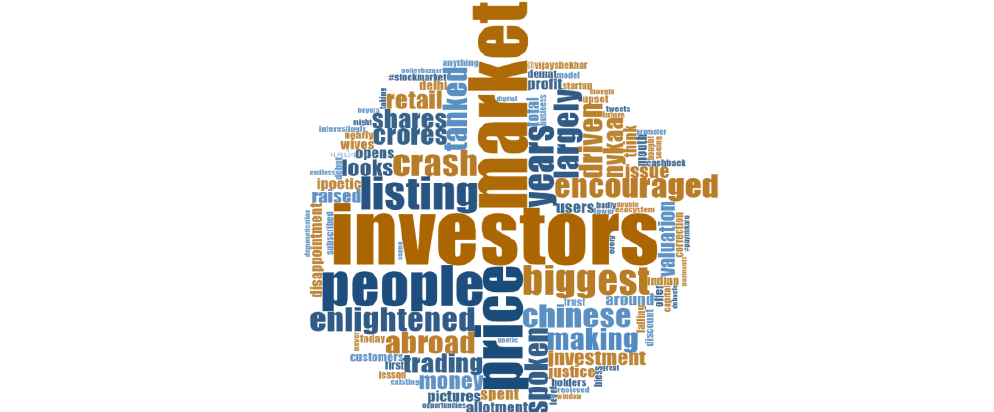
Figure 1. Word Cloud of Paytm